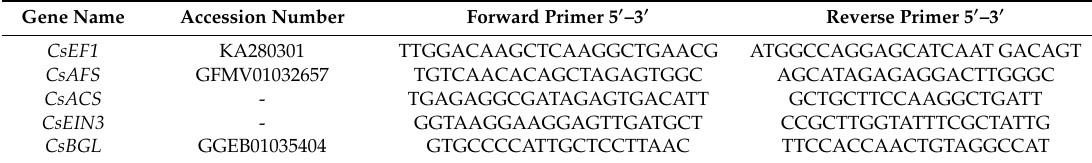
Table 2. Primers used for RT-qPCR analysis of genes involved in synthesis of α -farnesene and defense ability in tea